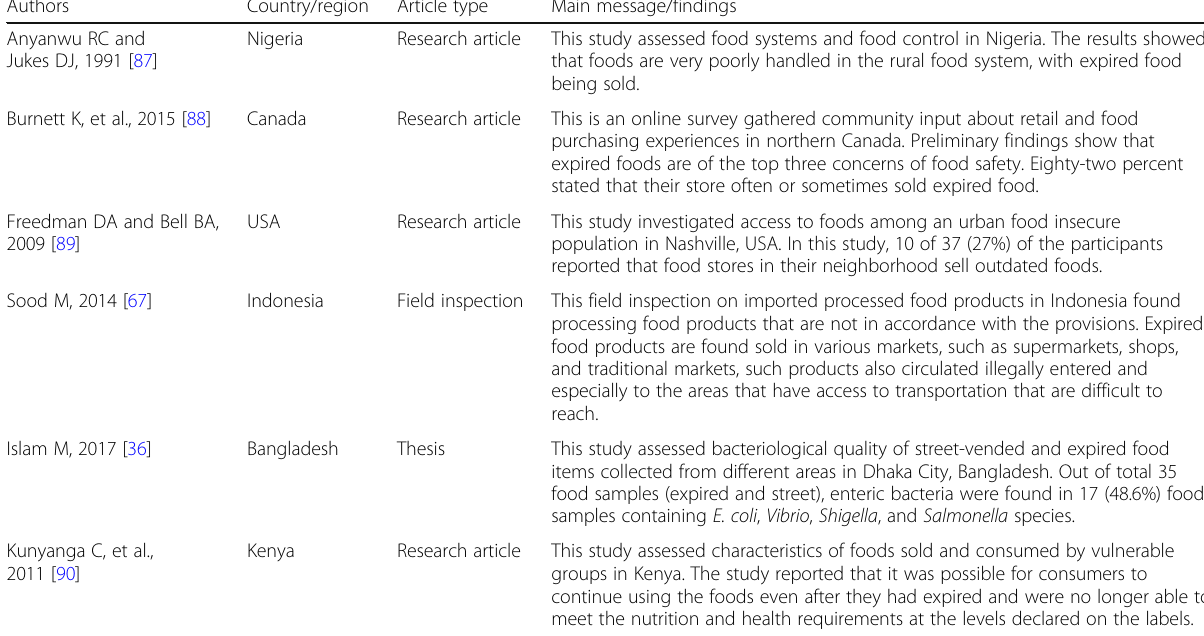
Table 9 Summary of full-text articles which reported foods past their use-by dates as a public risk in food